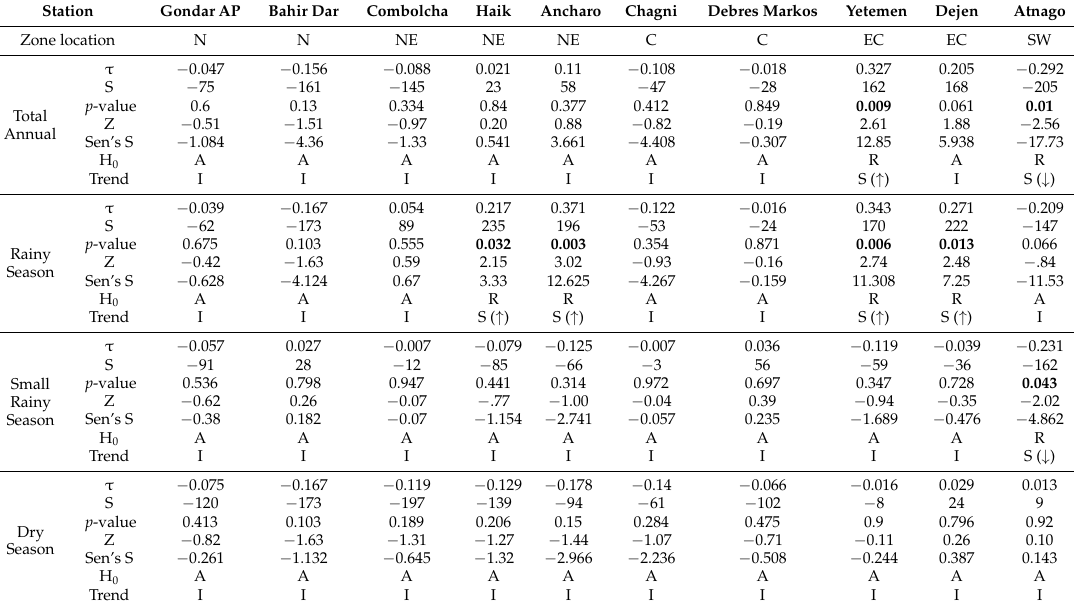
Table 2. Summary results of Mann–Kendall trend analysis for total annual and seasonal rainfall data.